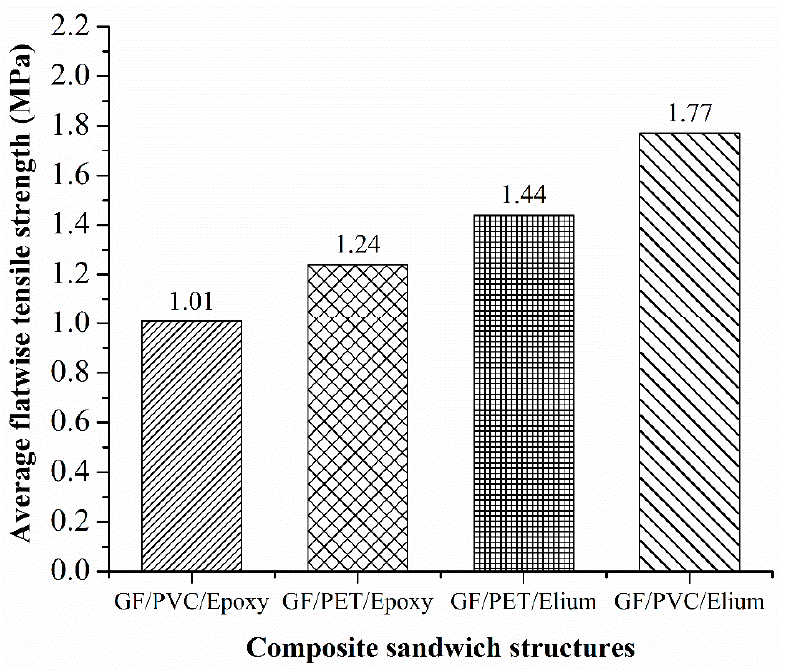
Figure 10. Flatwise strength of GFRP sandwich composite structures. Table 4. Highest peak load and flatwise strength of GFRP sandwich composite structures. Sandwich Structures Sample